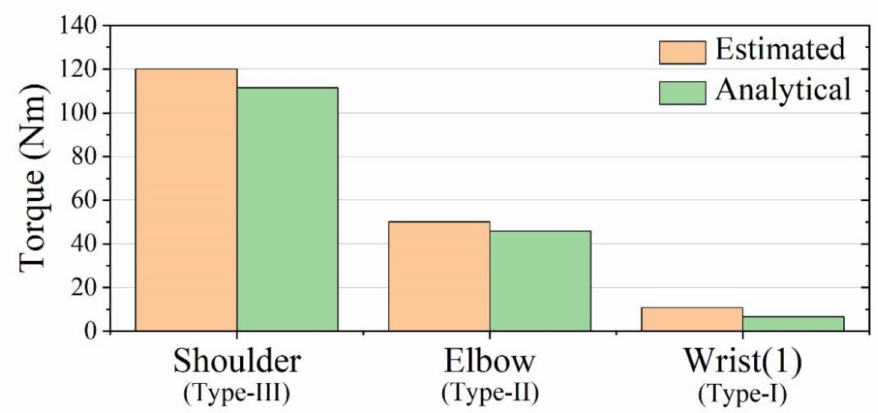
Figure 18. Comparison of the estimated and analytical values of the maximum torque for each smart